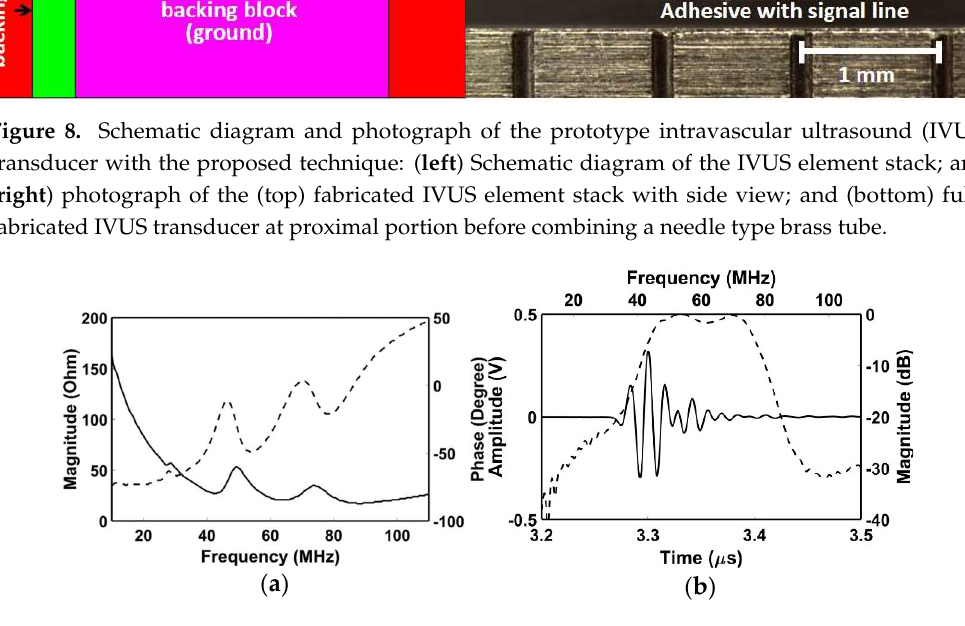
Figure 9. Measured results of the proposed IVUS transducer: ( a ) Electrical impedance (solid line—magnitude; dashed line—phase); and ( b ) pulse-echo response (solid line—time-domain response, dashed line—frequency-domain response).